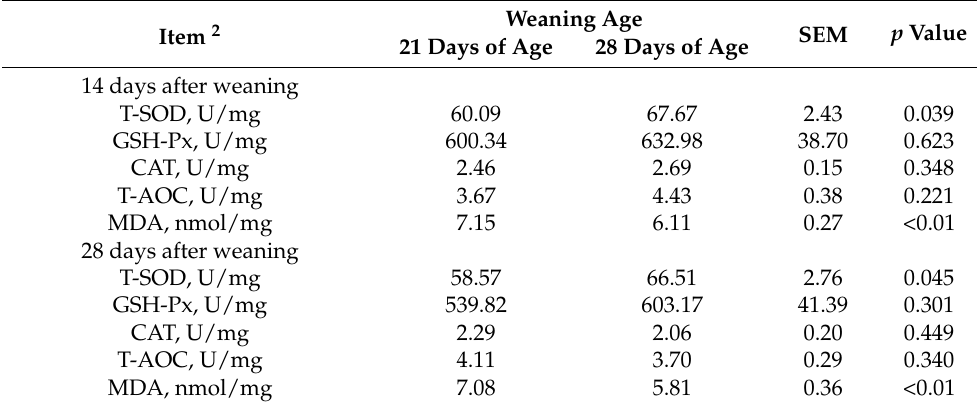
Table 9. Effect of weaning age on liver antioxidant indexes of weaned pigs 1 .